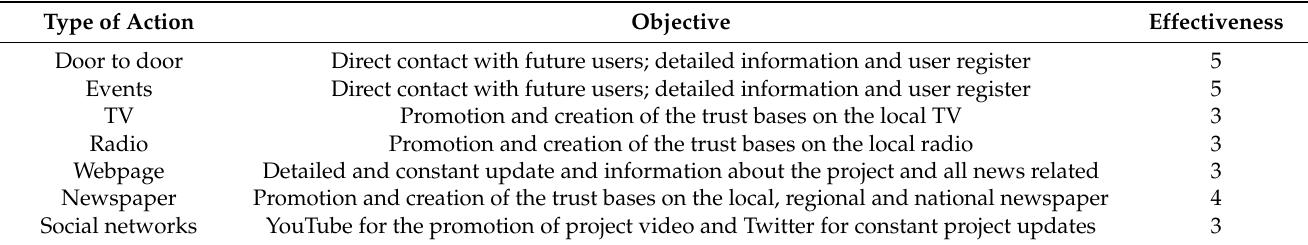
Table 5. Type and role of